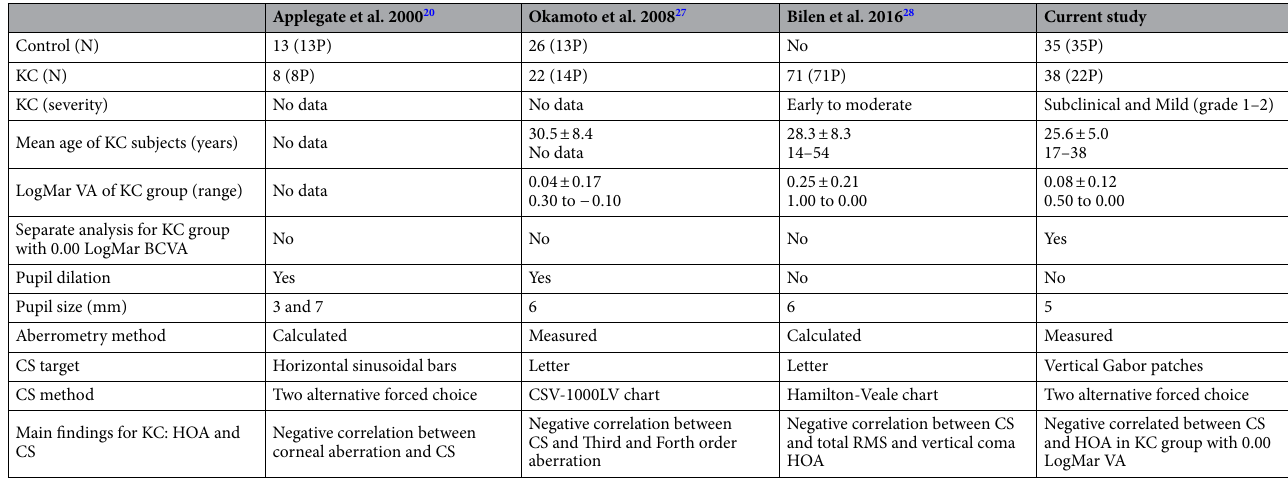
Table 4. Description of studies that evaluated contrast sensitivity and higher-order aberrations in keratoconus subjects. N, numbers of eyes; P, numbers of participants; KC, keratoconus; CS, contrast sensitivity; RMS, root mean square; HOA, higher-order aberrations; deg, degree; VA, visual